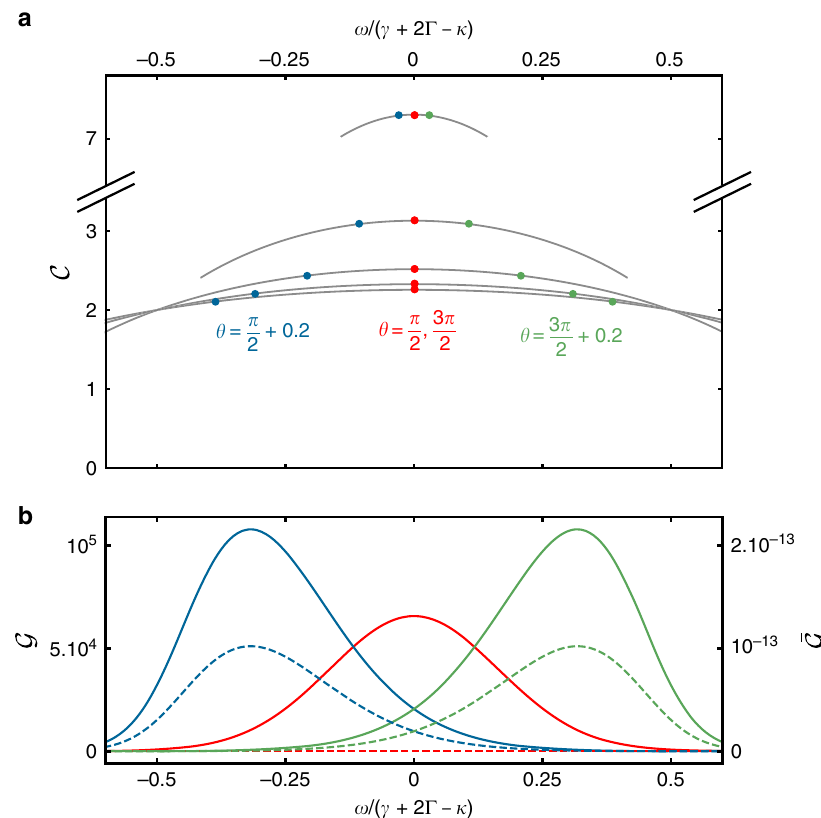
Fig. 7 Gain and reverse gain. In ( b ) we show the gain Gð ω Þ of Eq. (48) (solid line) and reverse gain Gð ω Þ of Eq. (49) (dashed line) for C ¼ 1 : 5 for different θ . The gain is a product of Lorentzians of width ( γ + 2 Γ − κ ), cf. Eq. (51). The position of the divergences at larger C in a sets the position of the peak in gain ; 3 π and reverse gain. For θ ¼ π the peak is centered around ω = 2 2 Methods Exact expressions . We give here the exact expressions for I n and ϵ n arising in the derivation of our main results Eqs. (23) to (29) — the one-to-one correspondence between a non-trivial winding number and directional ampli fi cation. χ obc is cru- H P 0 1 cially determined by I n (cid:5) d ~ z ~ z n (cid:3) mN (cid:3) 1 , see Eq. (23). We can calculate m ¼(cid:3) 1 j ~ z j¼ 1 h ð ~ z Þ 2 π i